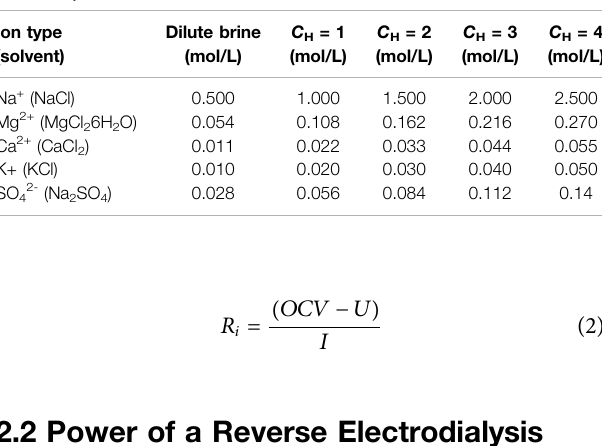
TABLE 4 | Ion concentration in feed